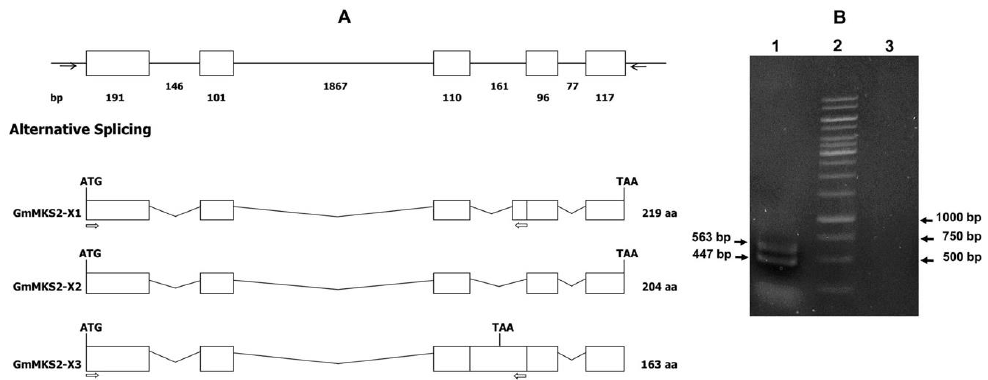
Figure 1. Schematic diagram of the Glycine max methylketone synthase 2 ( GmMKS2 ) gene and detection of its alternatively spliced products. ( A ) Schematic genomic organization of GmMKS2 and alternative RNA splicing to generate GmMKS2-X1 , -X2 , and -X3 transcript variants. Exons are represented as boxes, and introns are represented as lines. The sizes (bp) of exons and introns are shown below the boxes and lines. Forward and reverse primers utilized for the amplification of the transcript variants X1, X2, and X3 are indicated by black arrows; ( B ) Detection of GmMKS2-X1 and GmMKS2-X3 transcripts using a forward primer located in the first exon and a reverse primer located in the last 45 nucleotides of intron 3, inserted in-frame between exon 3 and 4. Lane 1: two fragments corresponding to the first 447 and 563 nucleotides of GmMKS2-X1 and GmMKS2-X3 , respectively; lane 2: DNA ladder; lane 3: negative control.